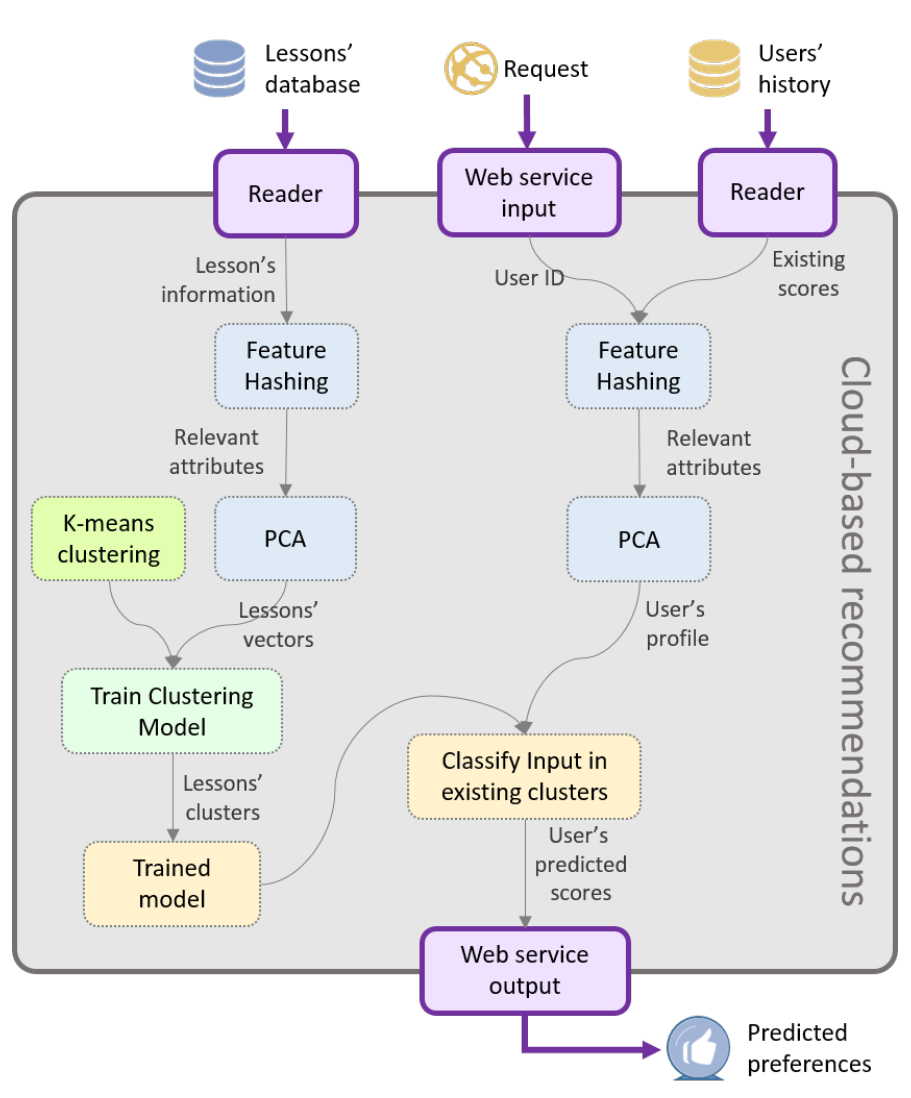
Figure 10. Cloud-based lesson